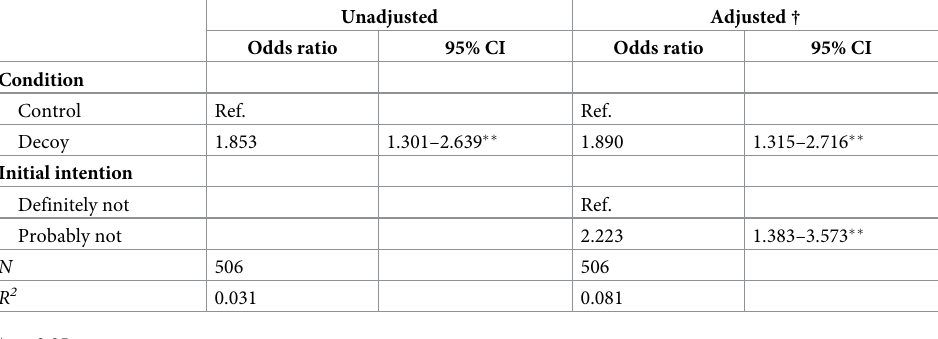
Table 1. Logistic regression models on choosing the target hospital.